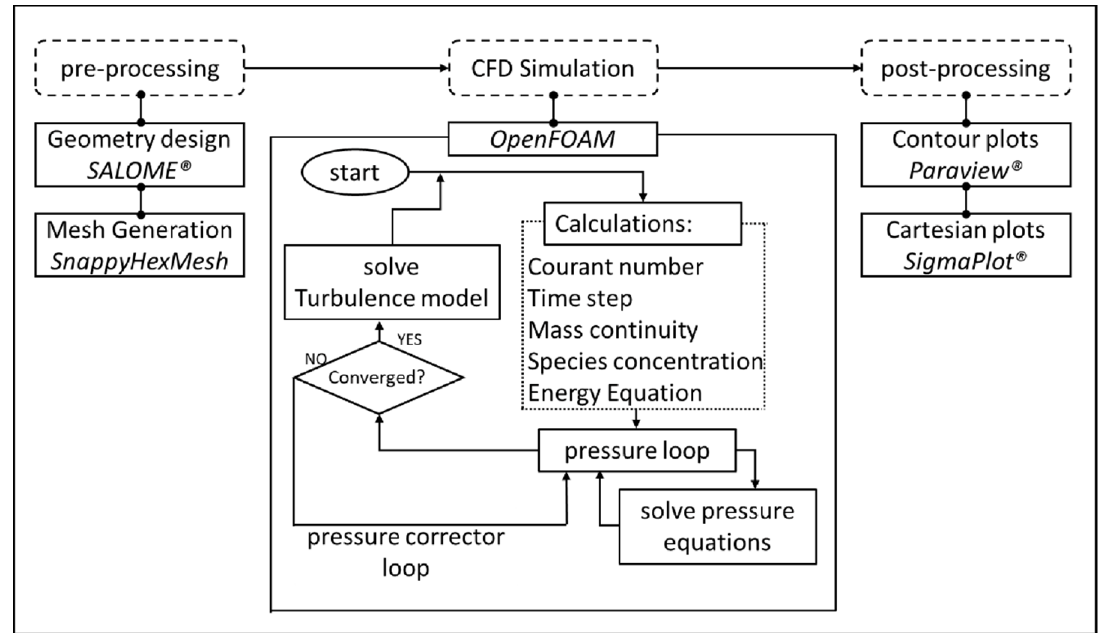
Figure 3. Summary of the computational fluid dynamics (CFD) solution strategy.